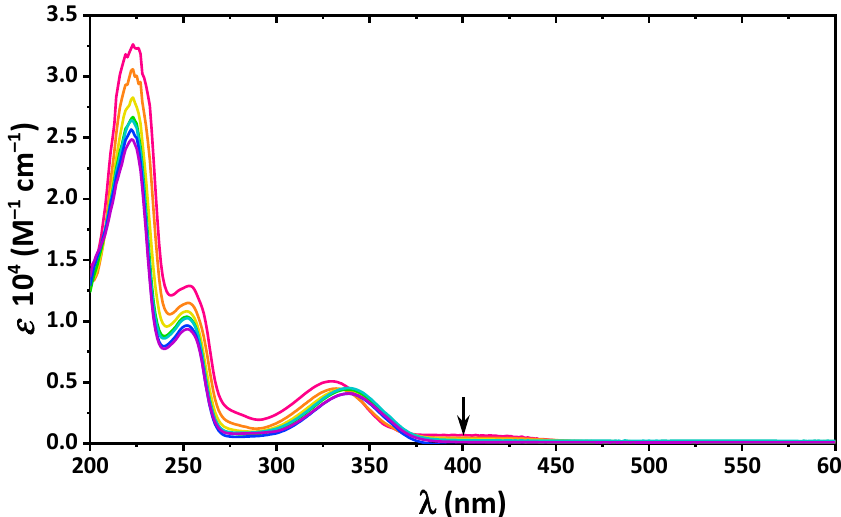
Figure 7. UV-vis spectra of 3 in EtOH upon gradual addition of CH 3 SO 3 H up to 3.5 eqv., with a step of 0.5 eqv.